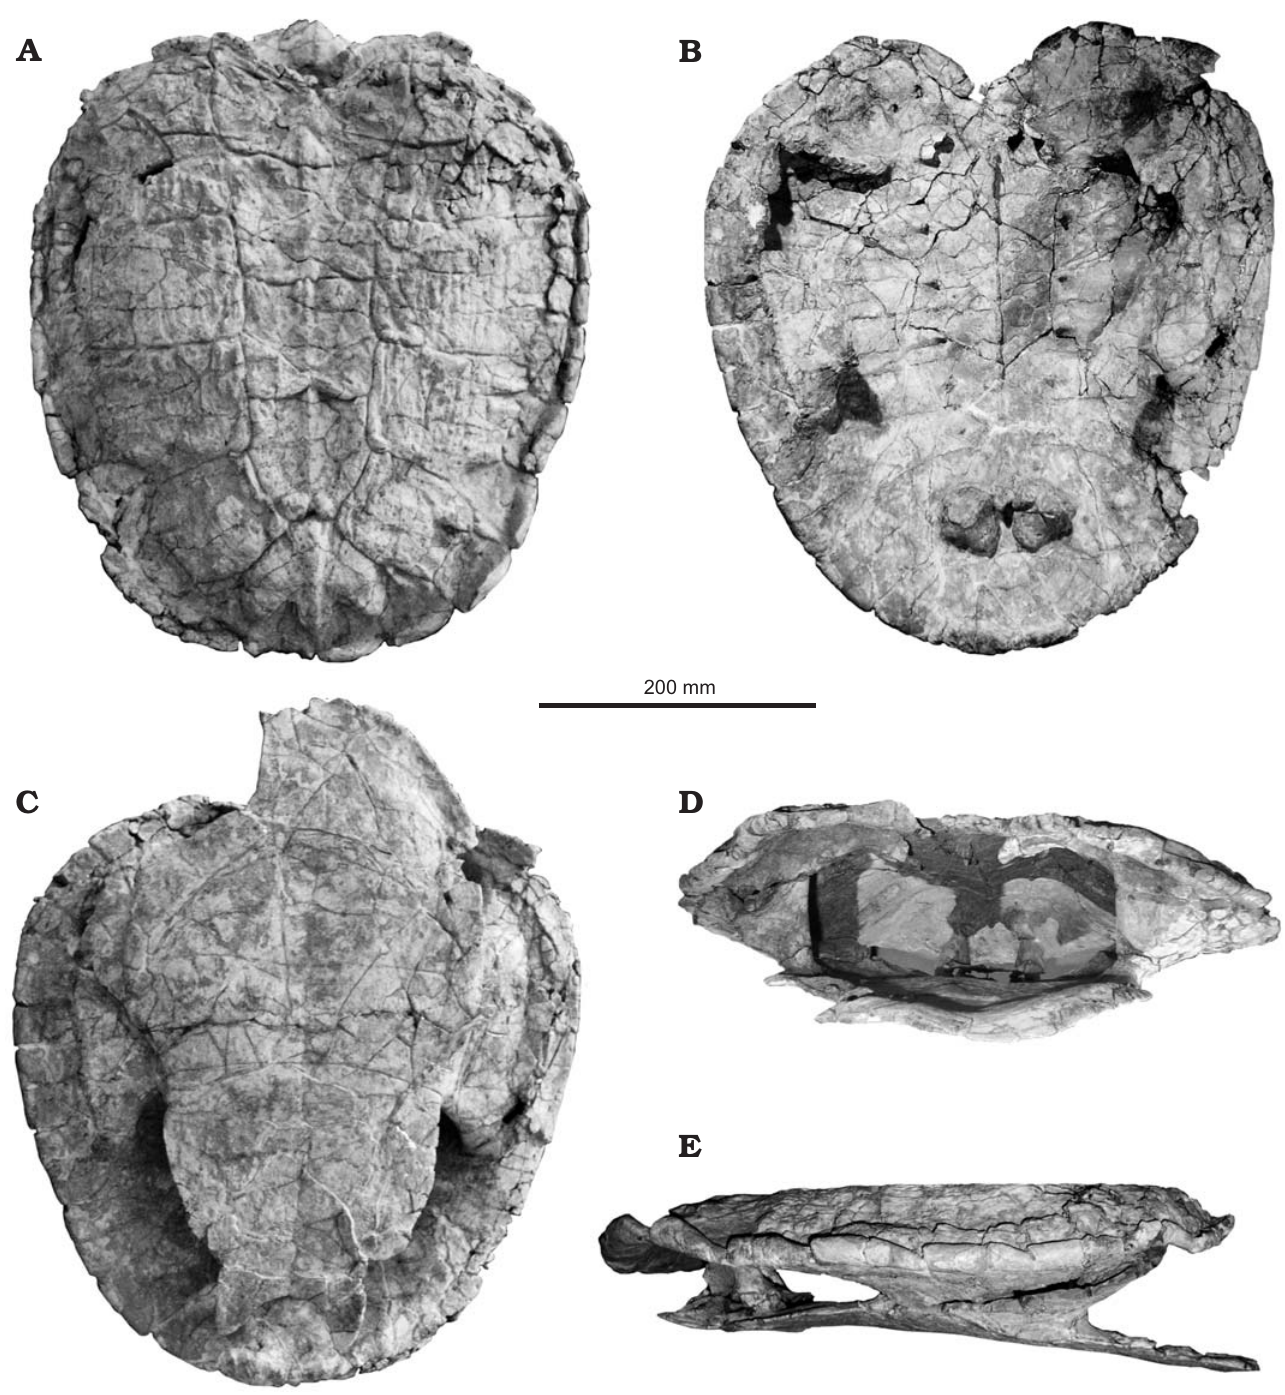
Fig. 4. Photographs of the holotype of the panchelid turtle Rionegrochelys caldieroi gen. et sp. nov. (MPCA-AT 258) from Parrita site, Upper Cretaceous. Carapace in dorsal ( A ) and visceral ( B ) views. Plastron in ventral view ( C ). Carapace and plastron in anterior ( D ) and lateral ( E ) views. Note suturally attached pelvic